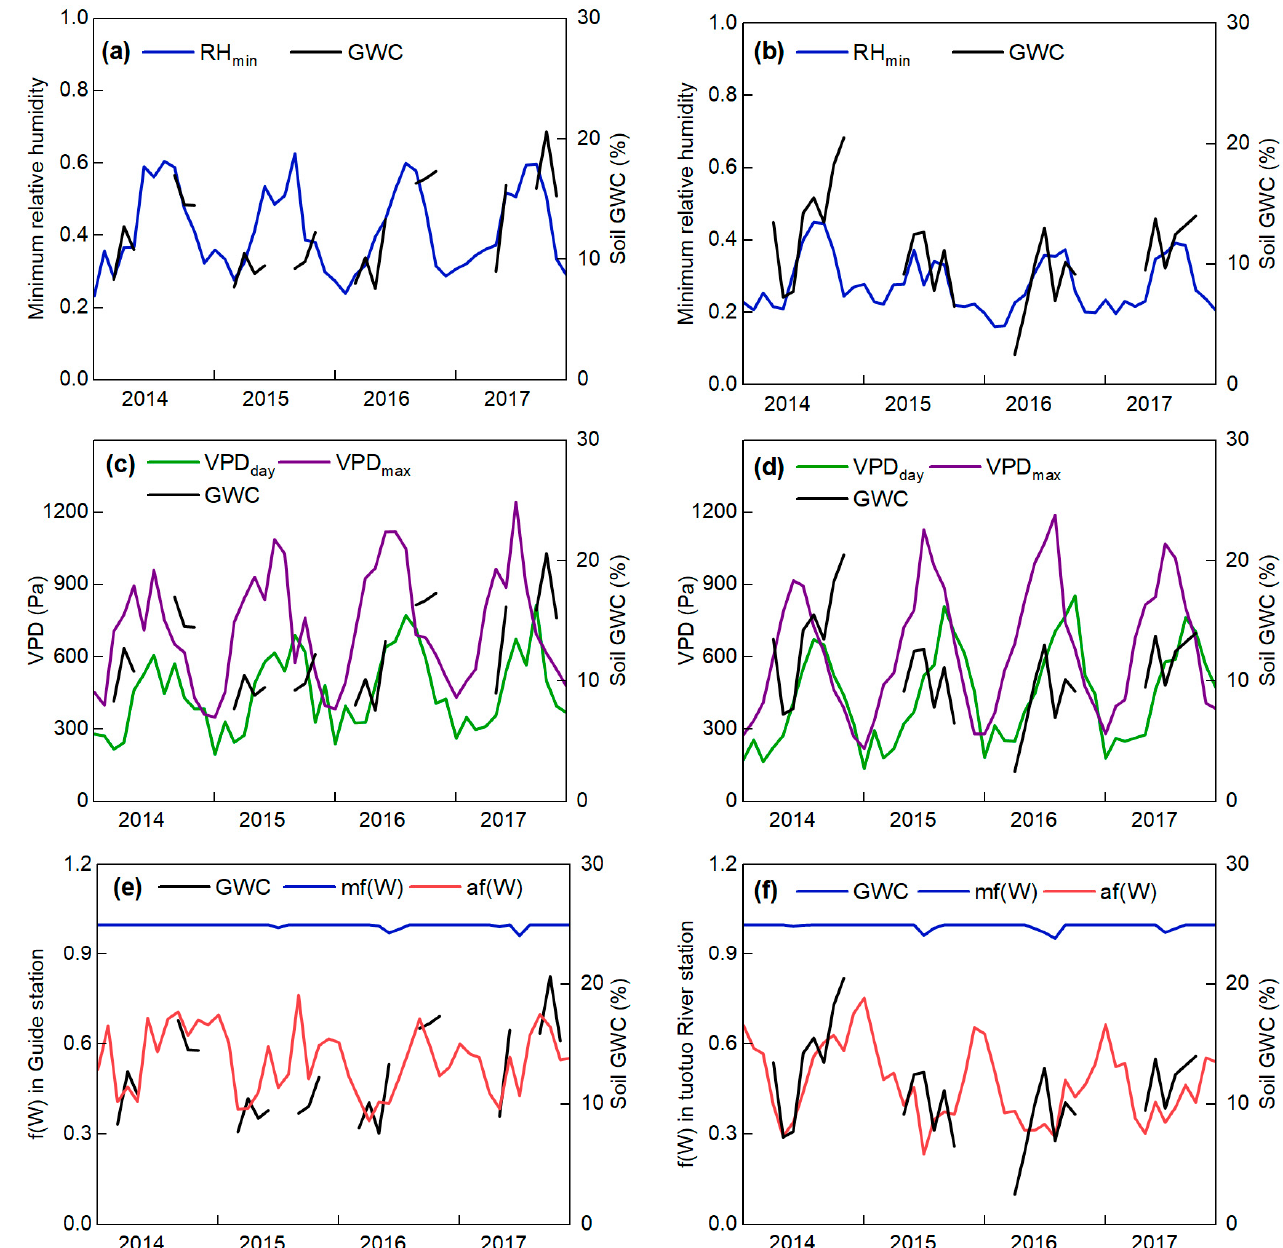
Figure 5. Patterns of minimum relative humidity (RH min ), soil gravimetric water content (GWC), vapor pressure deficit (VPD), daytime VPD (VPD day ), maximum VPD (VPD max ), MOD17 water stress (mf(W)), and AVPM water stress (af(W)) during 2014–2017 at Guide station ( a , c , e ) and Tuotuo River station ( b , d , f ).